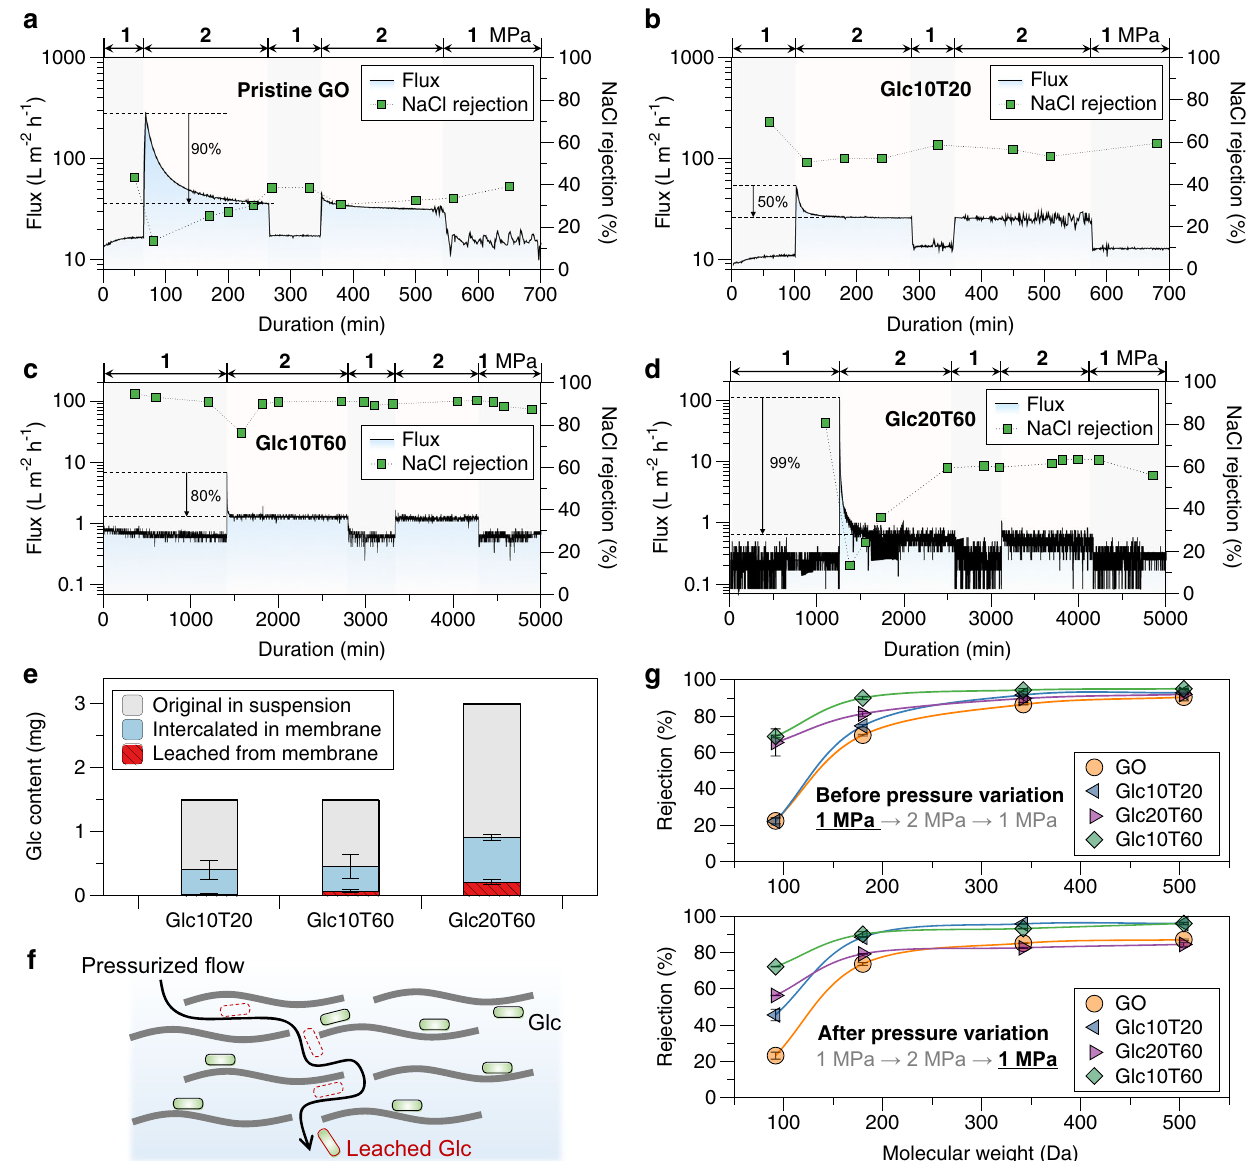
Fig. 5 | Nanochannel deformation and performance in pressure-changing reverseosmosis. FiltrationofNaClsolutionswithpressurevariationsby( a )GO,( b ) Glc10T20, ( c ) Glc10T60, and ( d ) Glc20T60; ( e ) Glc content in original membrane precursor suspension, intercalated Glc content in prepared membranes, and lea- ched Glc content from membranes during permeation test. The error bars